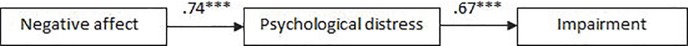
Empirically supported model of disruption to home/family activities during the week before completing a shift on the crisis line.